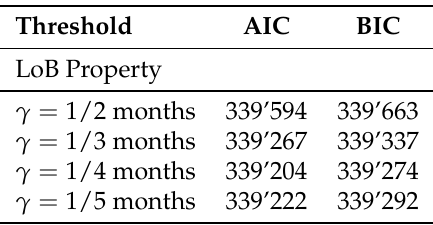
Table 6. AIC and BIC as of 31/10/2010 for LoB Property truncated/truncated dynamic log-normal model with u ( 2 ) = 6 months.